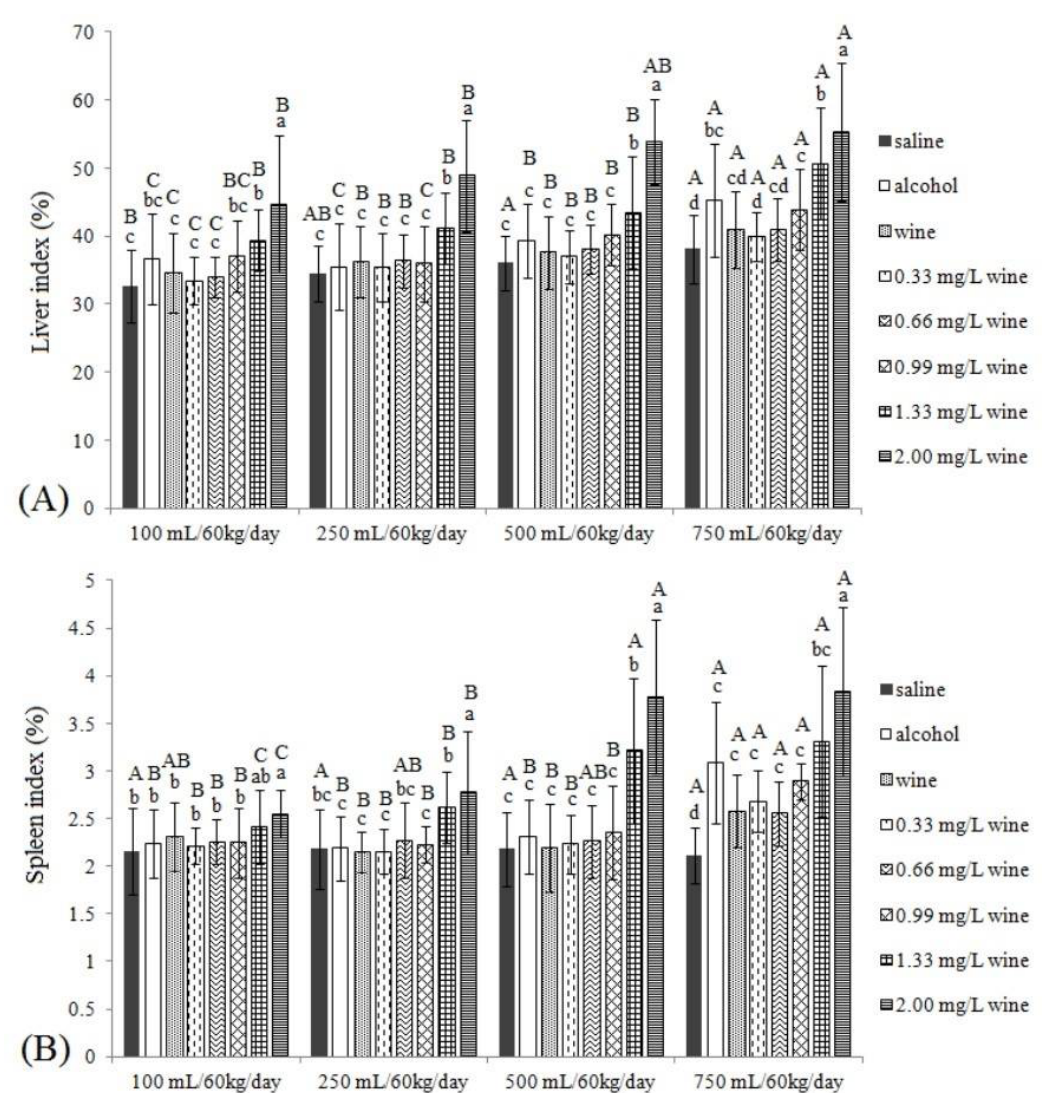
Figure 2. The liver indices ( A ) and spleen indices ( B ) of mice. Different capital letters indicate significant differences between treatment groups, and different lowercase letters indicate significant differences within the same dose groups ( p < 0.05).